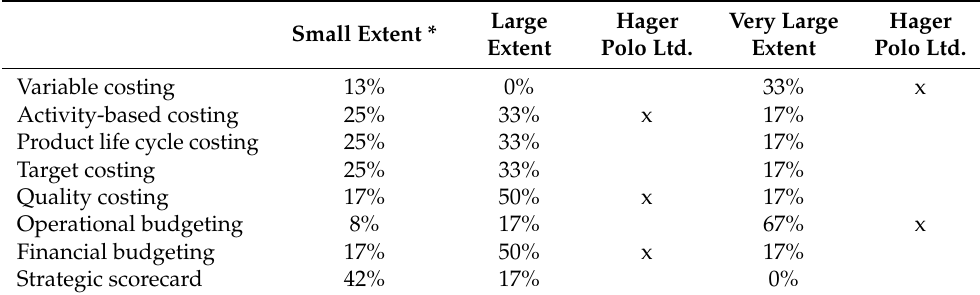
Table 3. Assessment of the managerial accounting tool use in operational decision making. Large Hager Very Large Hager Small Extent * Extent Polo Ltd. Extent Polo Ltd. Variable costing 13% 0% 33% x Activity-based costing 25% 33% 17% Product life cycle costing 25% Target costing Quality costing 17% Operational budgeting 8% 17% 67% x Financial budgeting 17% 50% x 17% Strategic